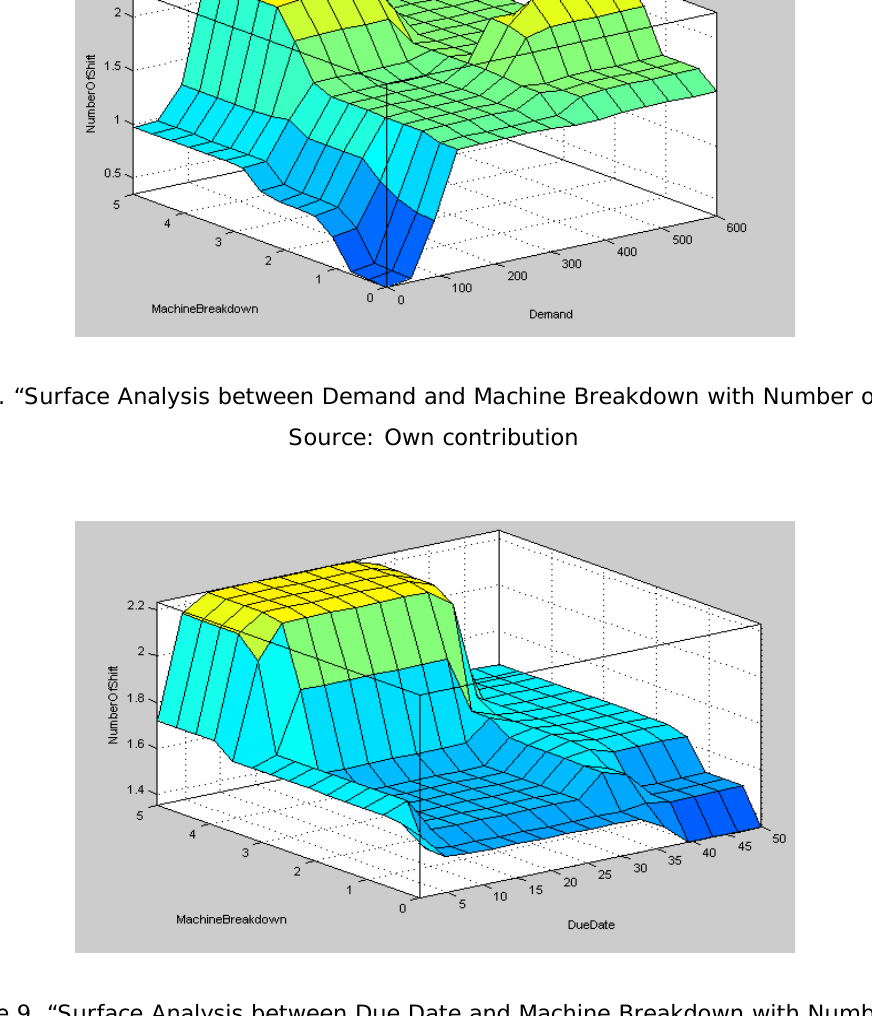
Figure 9. “Surface Analysis between Due Date and Machine Breakdown with Number of Shift”. Source: Own